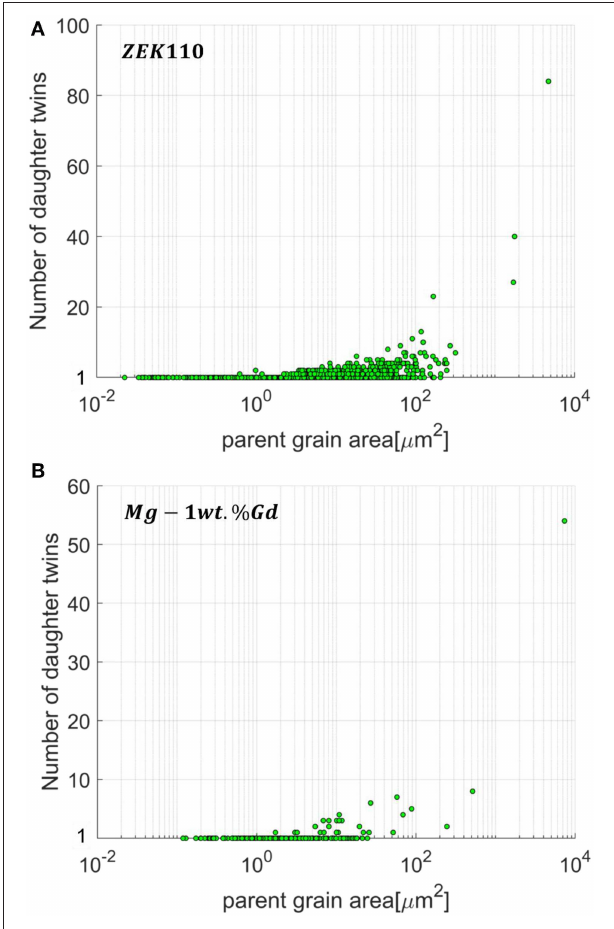
FIGURE 7 | Number of first generation twins per parent as a function of grain size for (A) ZEK110 and (B) Mg-1Gd from Basu and Al-Samman